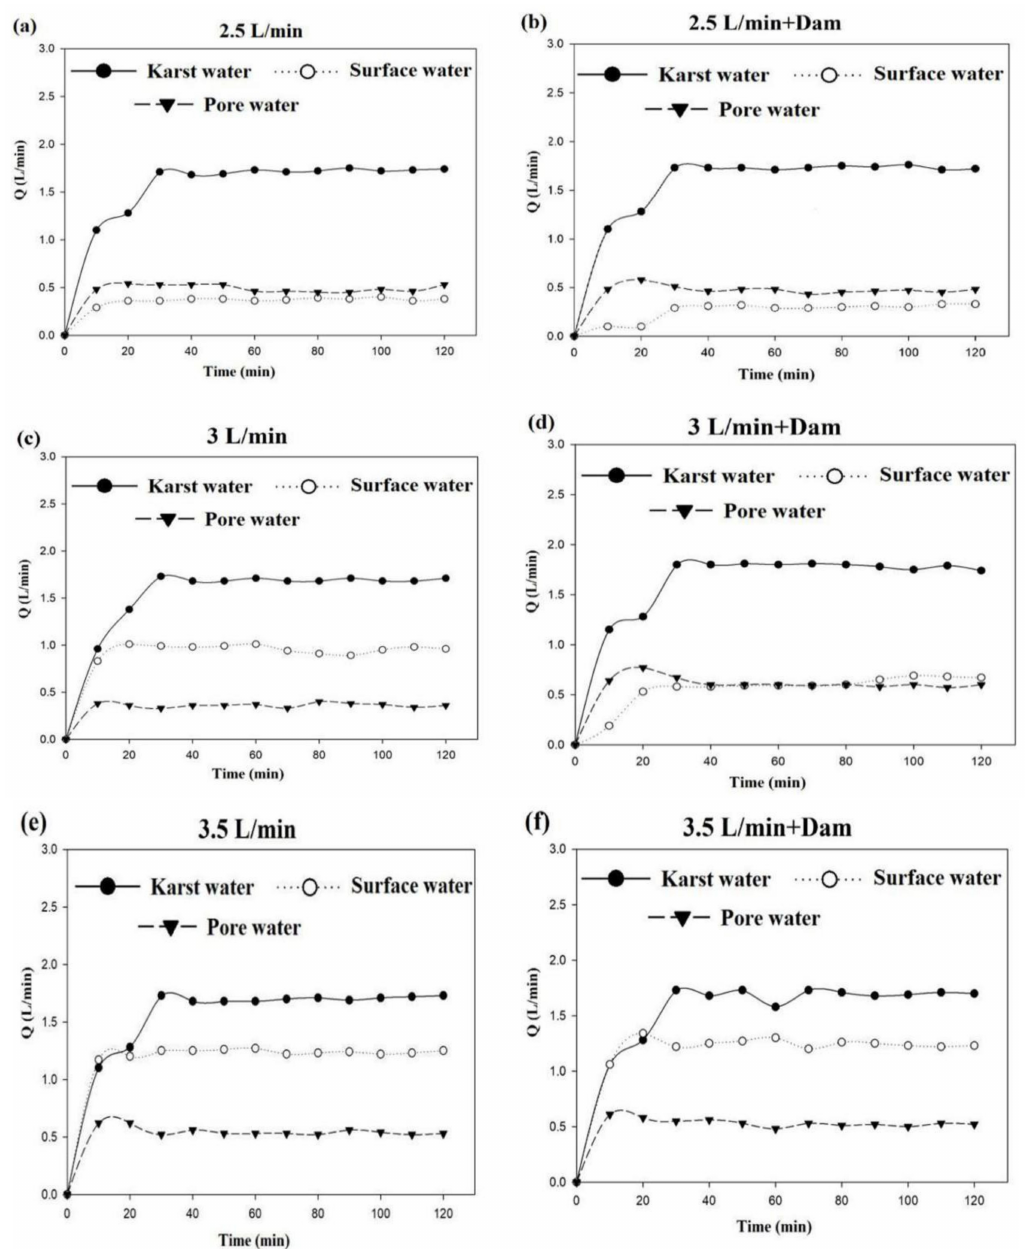
Figure 5. ( a , c , e ) Flow curves of surface water, pore water, and karst water when the river water release rate is 2.5, 3, and 3.5 L/min, respectively. ( b , d , f ) Flow curves of surface water, pore water, and karst water when the river water release rate is 2.5, 3, and 3.5 L/min, respectively, after the rubber dam is built in the